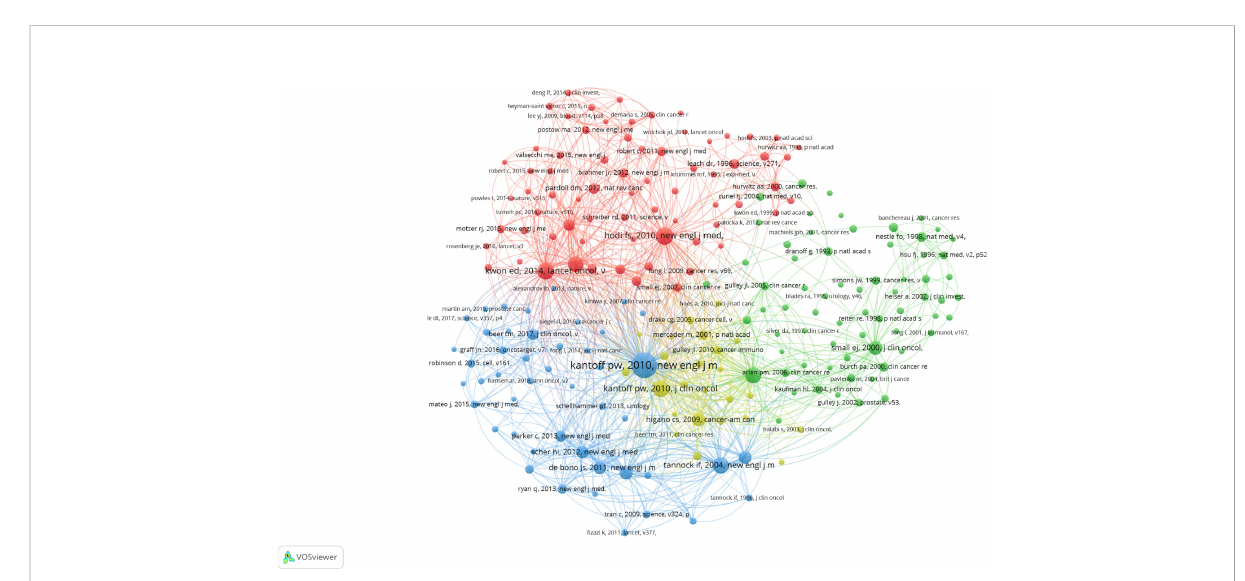
FIGURE 5 The visualization network of co-cited references in PCa immunotherapy.